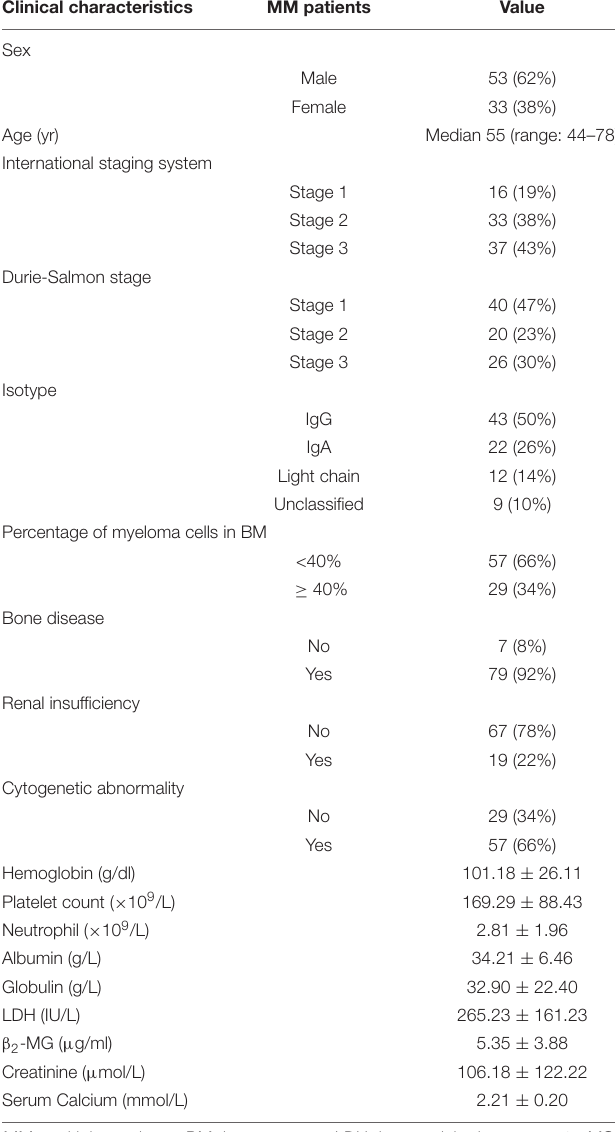
TABLE 1 | Characteristics of study population. Clinical